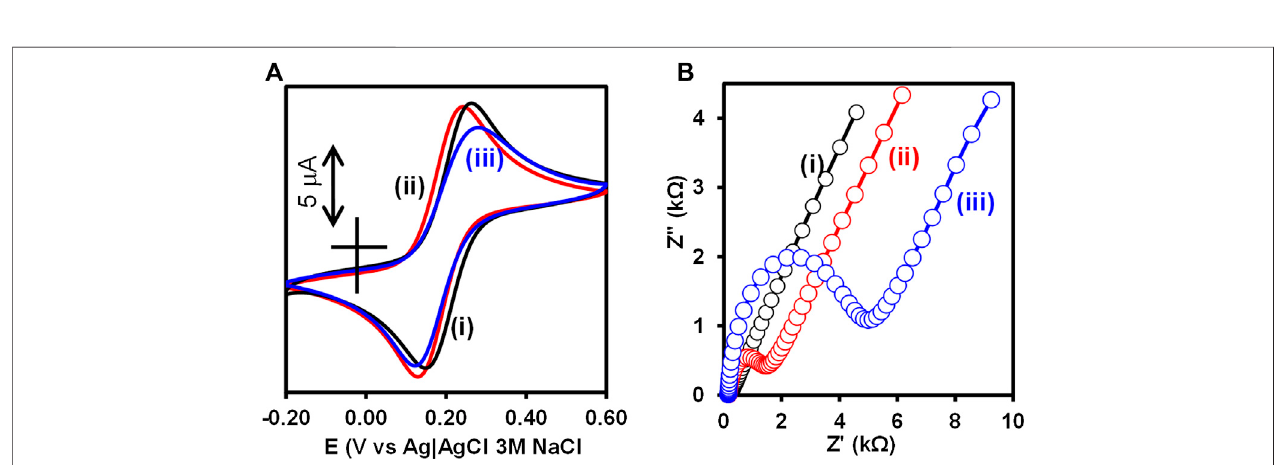
FIGURE 1 | (A) Cyclic voltammograms and (B) Nyquist plot of (i) bare Au, (ii) Au-MBA-APBA SAM, and (iii) Au-MBA-APBA-mAb/glucose in (1:1) 2 mM K 3 Fe(CN) 6 :